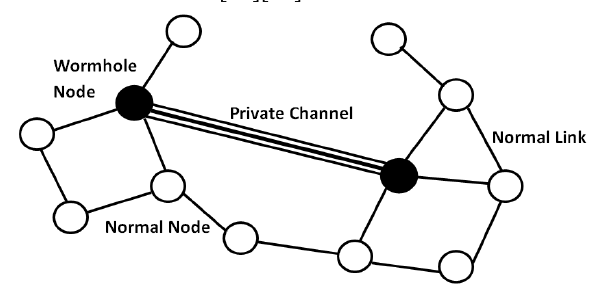
Figure 1. Wormhole attack in MANET